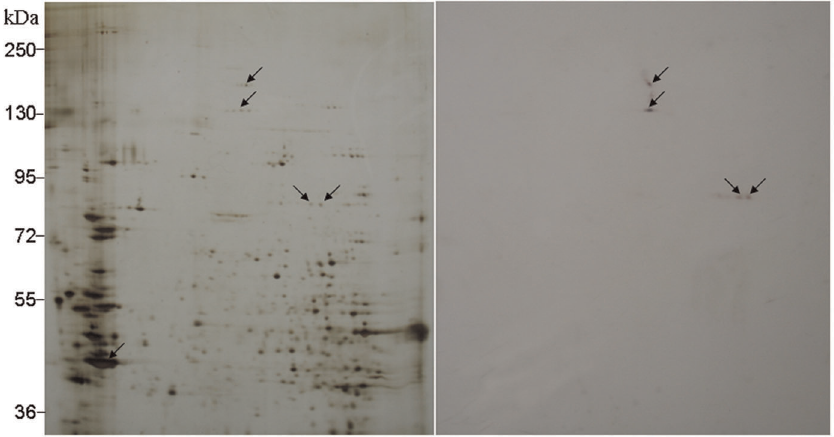
Figure 4. Blot analysis of Cry1Ac binding proteins in Chilosuppressalis midgut. Proteins were separated by 2D-gel electrophoresis. Arrows denote positions of the Cry1Ac binding proteins. To detect Cry1Ac binding proteins, filters were probed with biotin-Cry1Ac. Positions of molecular size markers (kDa) are indicated on the side of gel.